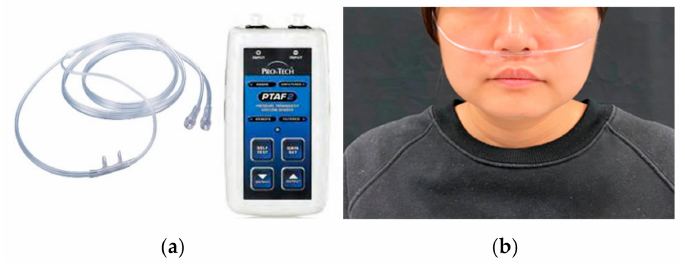
Figure 3. Respiration measurement: ( a ) nasal cannula and transducer, ( b ) placement of the nasal cannula.